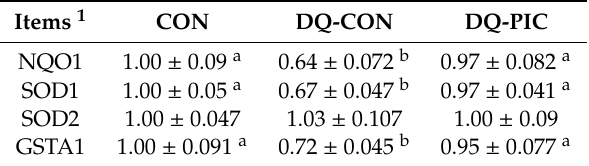
Table 6. E ff ects of piceatannol supplementation on expression levels of antioxidant genes in the liver of diquat-induced